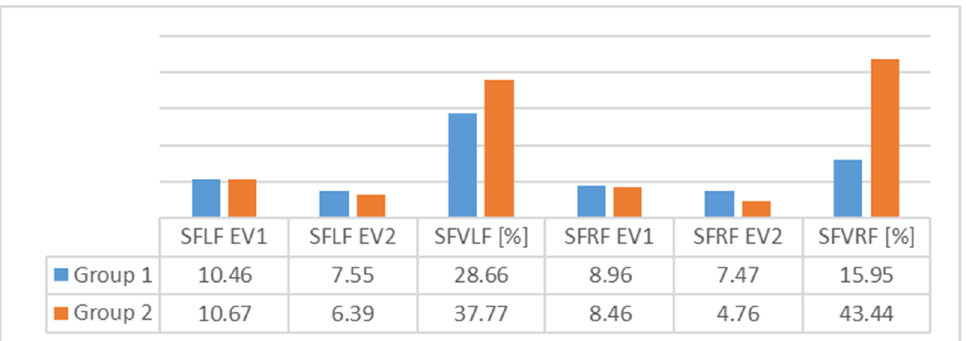
Figure 7. Average values for subtalar flexibility—comparison between the two groups (SFLF = subtalar flexibility for left foot; SFVLF = subtalar flexibility variation for left foot; SFRF = subtalar flexibility for right foot; SFVRF = subtalar flexibility variation for right foot).